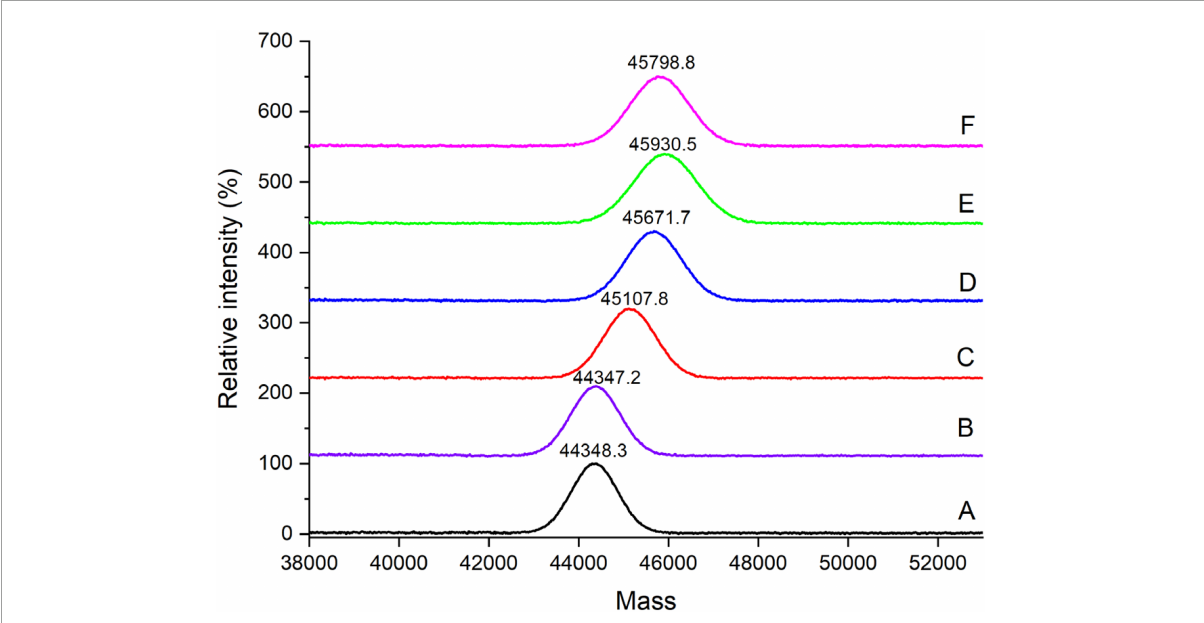
FIGURE2 MALDI–TOF mass spectra of ovalbumin (OVA) samples. A–F represents OVA-N, OVA-H, OVA-P, OVA-P-20, OVA-P-25, and OVA-P-30, respectively.